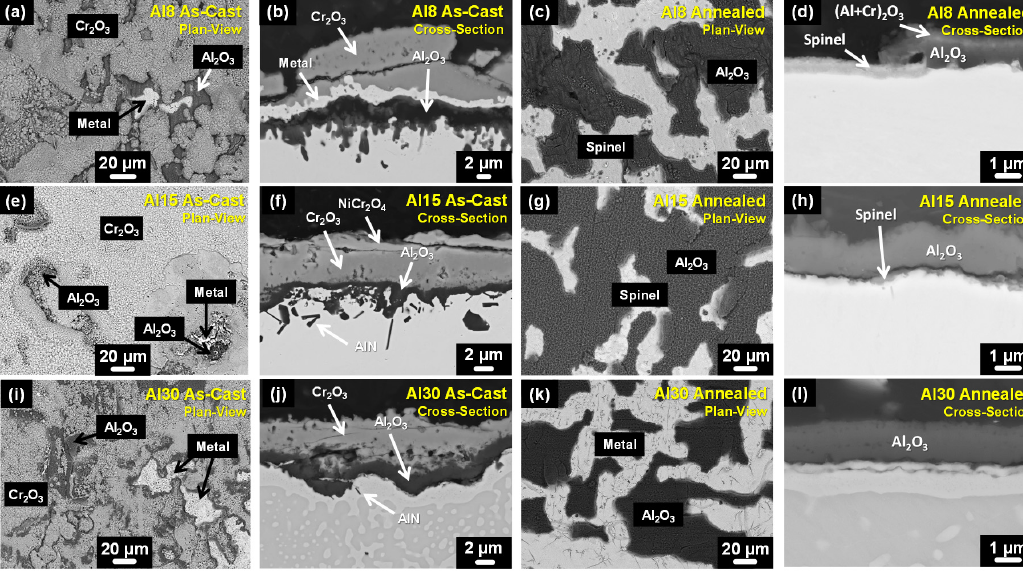
Figure 3. Plan ‐ view and cross ‐ sectional BSE micrographs for the as ‐ cast and annealed Al 8 ( a – d ); Al 15 Figure 3. Plan-view and cross-sectional BSE micrographs for the as-cast and annealed Al 8 ( a – d ); ( e – h ); and Al 30 ( i – l ) HEAs after 50 h of oxidation at 1050 °C. Al 15 ( e – h ); and Al 30 ( i – l ) HEAs after 50 h of oxidation at 1050 ◦